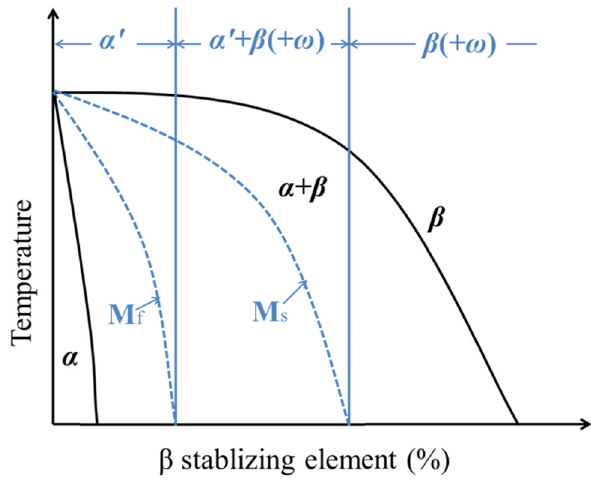
Table 1. All the solution - treated specimens were Figure 1: Pseudobinary phase diagram of titanium